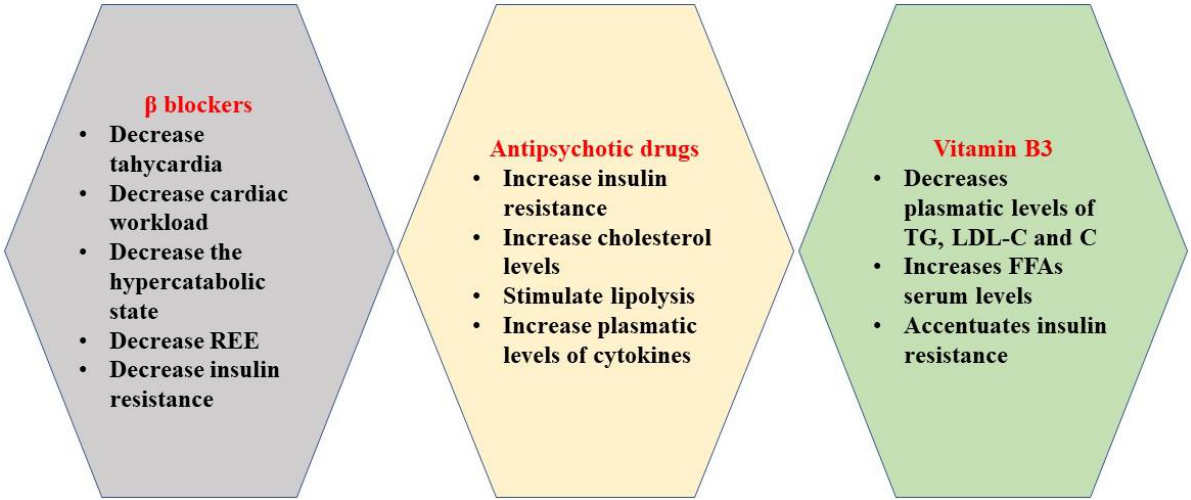
Figure 2. Effects of β blockers, antipsychotic drugs, and vitamin B3.